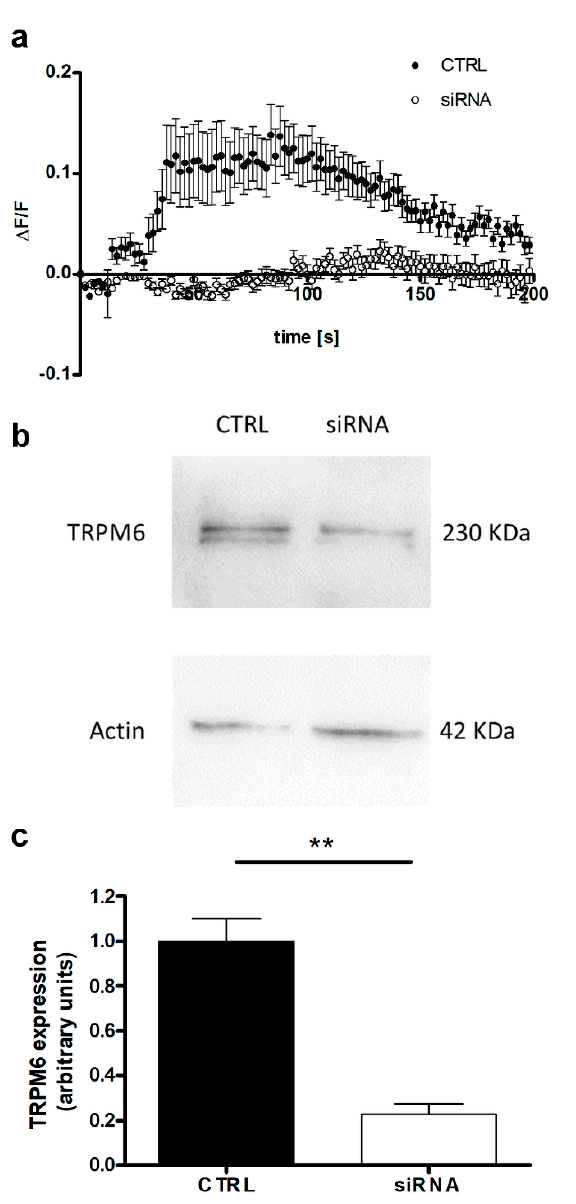
Figure 1. The TRPM6 channel mediates the Mg influx in human colon carcinoma cells. CaCo-2 cells were transiently silenced for TRPM6 (siRNA) and assessed 48h after transfection. Control cells (CTRL) received non-silencing scrambled siRNA. ( a ) Mg influx capacity in TRPM6-silenced (open circles) vs. control cells (solid circles), as assessed by the live imaging of Mag-Fluo-4-loaded cells; a representative experiment is shown. ( b ) TRPM6 protein expression in TRPM6-silenced and control cells, as evaluated by Western blot analysis; a representative blot is shown. ( c ) Quantification of TRPM6 protein expression by Western blot densitometry normalized to β -actin levels ( n = 3, mean ± SD) in TRPM6-silenced (white bar) and control (black bar) cells. ** p < 0.01 by paired Student’s t-test. Full scans of original blots are available in Figure S1.